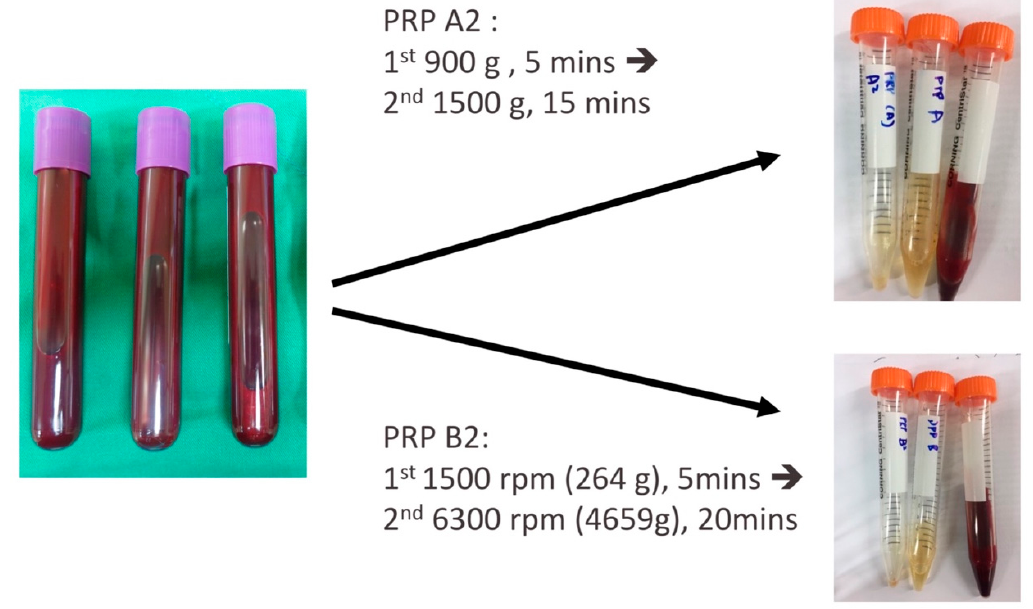
Figure 3. Two types of PRP preparations. PRP A2, 900 g for 5 min and then 1500 g for 15 min; PRP B2, 1500 rpm for 5 min and then 6300 rpm for 20 min.